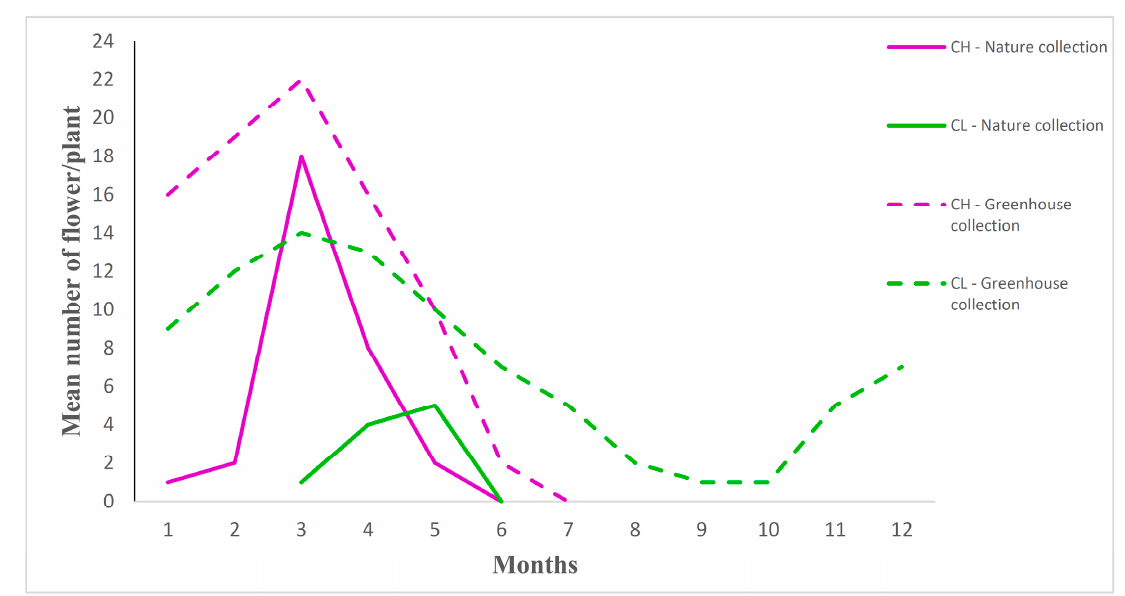
Figure 5. Number of CH and CL flowers per plant of Viola caspia developing during a season in Live Collection of Iranian Violets and in greenhouse conditions. N = 20. Five-year average results.